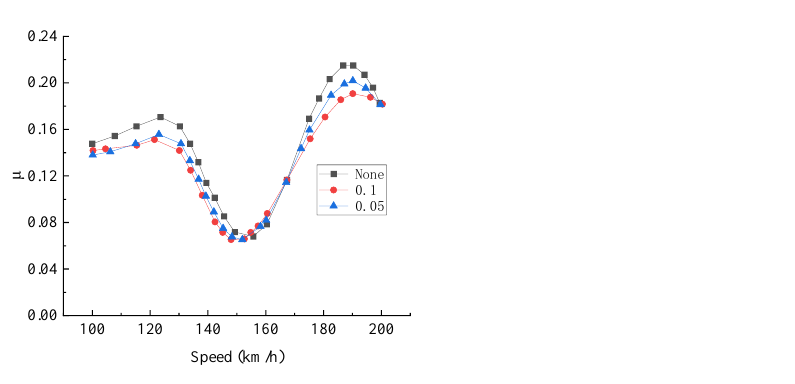
Figure 21. The impact coefficient varies with the damping ratio of trains crossing the bridge.